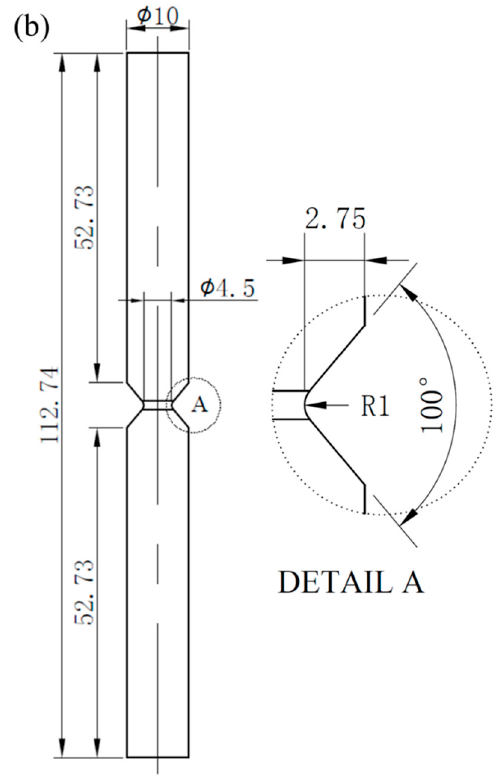
Figure 2. Shapes and dimensions (units: mm) of ( a ) smooth specimen and ( b ) notched specimen for ultrasonic fatigue tests; notch radius (R) is 1 mm.